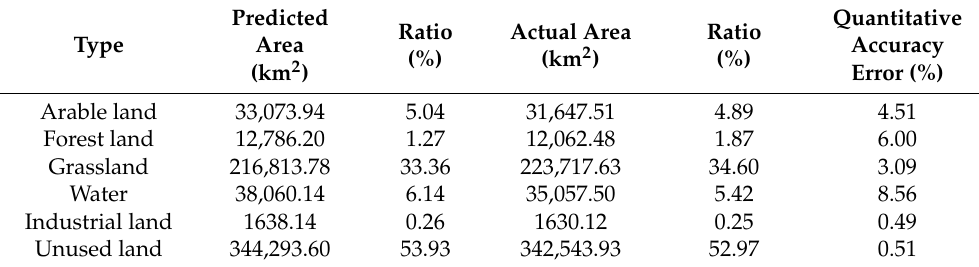
Table 2. Comparison between simulated and actual land use within the study area in